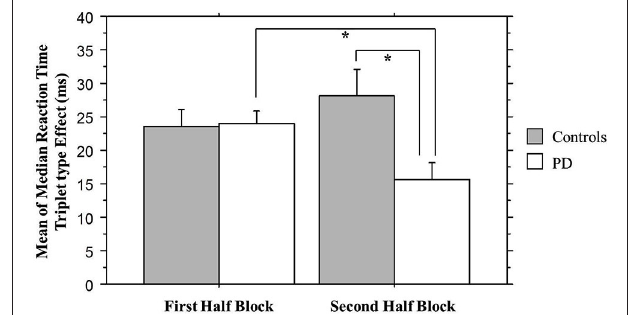
FIGURE 4 | Overall Half Block Triplet type effect (RT to Low Probability triplets – RT to High Probability triplets) by Group . Asterisks indicate a significant difference, p ’s = .01. Bars indicate standard